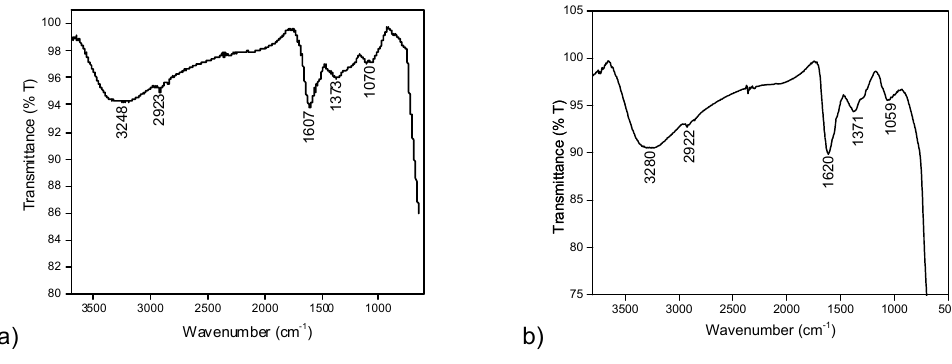
Figure 3. FTIR spectra of ( a ) JC-Fe 3 O 4 and ( b ) CT-Fe 3 O 4 NPs.